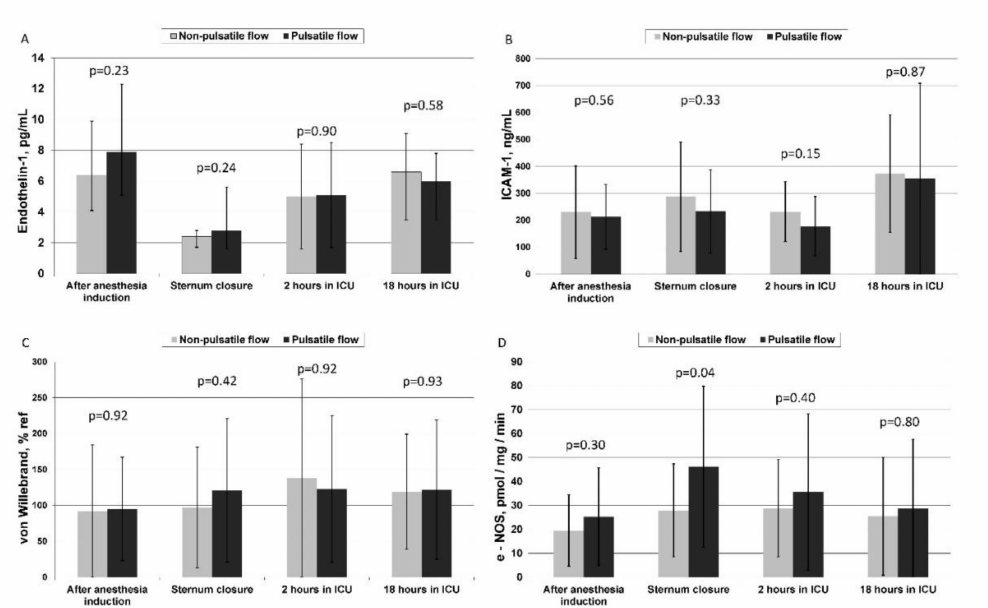
Figure 4. Diagrams of perioperative plasma levels of endothelial integrity markers and erythrocyte NOS activity during pulsatile and non-pulsatile perfusion Panel ( A ). Plasma levels of Endothelin-1 (ANOVA group-time interaction, p = 0.28) Panel ( B ). Plasma levels of ICAM-1 (ANOVA group- time interaction, p = 0.94). Panel ( C ). Plasma levels of von Willebrand Factor (ANOVA group-time interaction p = 0.77). Panel ( D ). Erythrocyte e-NOS activity (ANOVA group–time interaction p = 0.08).